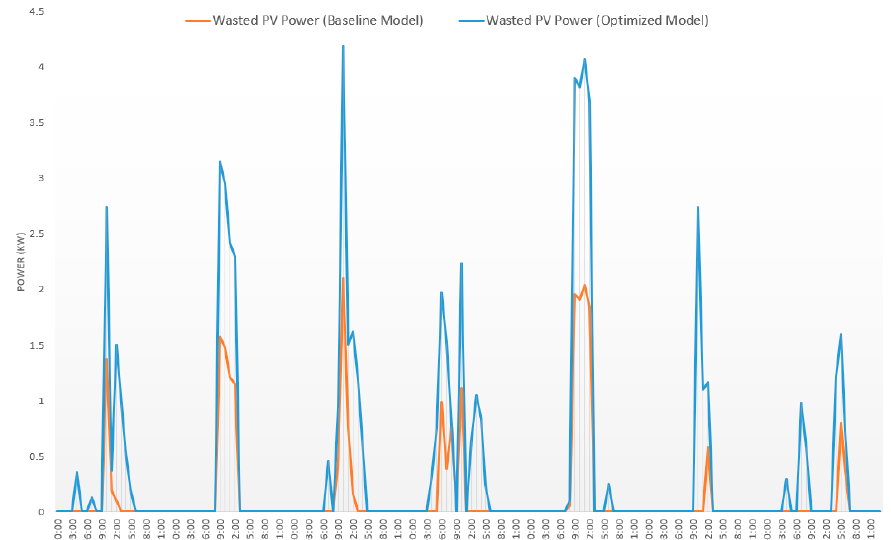
Figure 7. Summer week wasted grid photovoltaic (PV) energy comparison between the baseline load model and optimized load model.